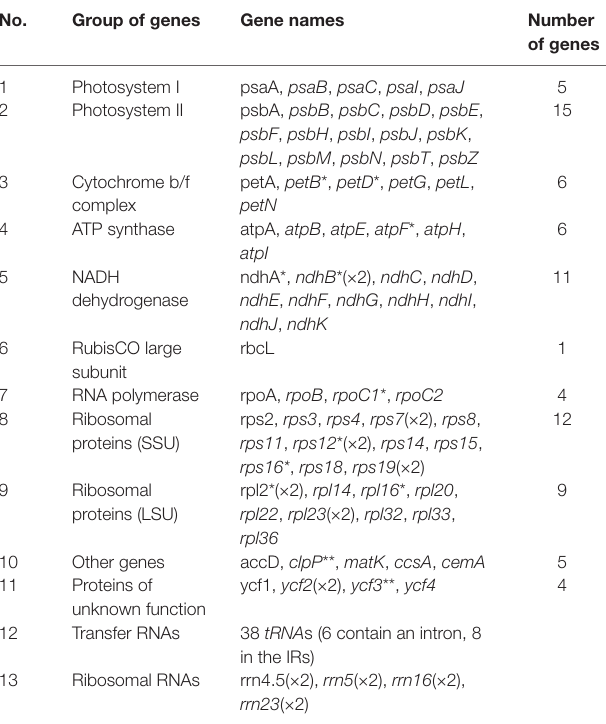
TaBLe 2 | List of genes found in the six CP genomes of Dracaena species.